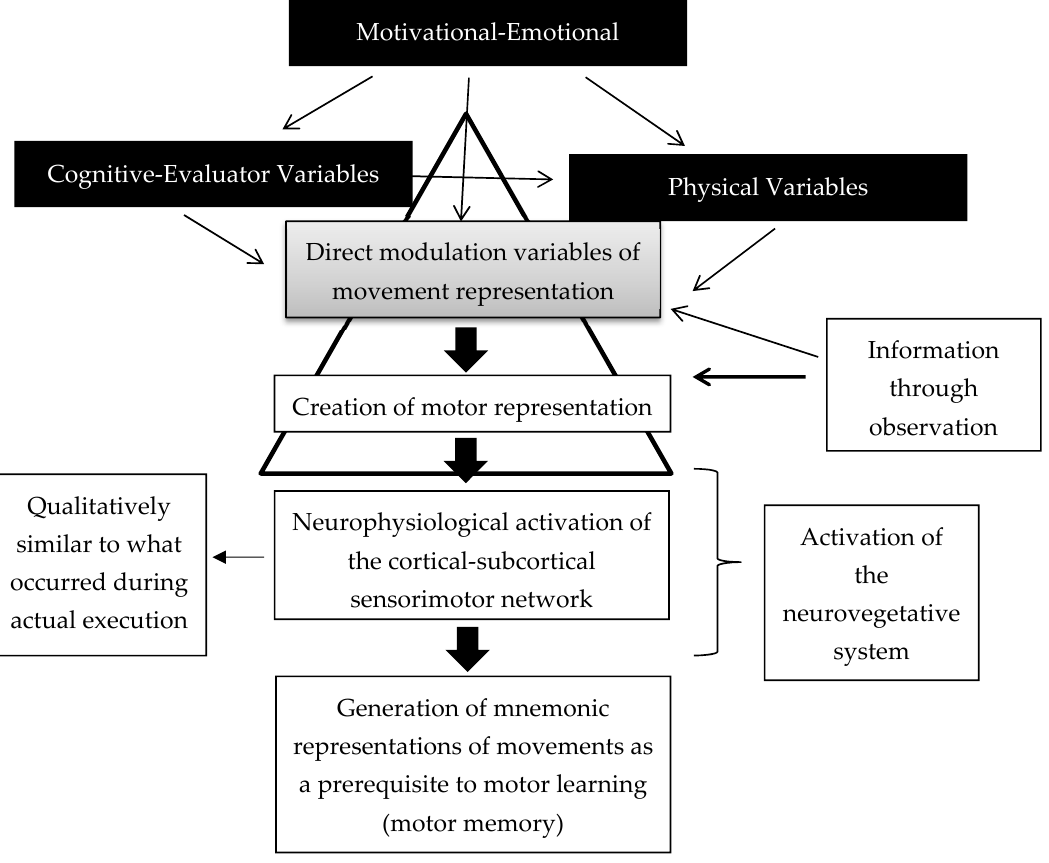
Figure 1. Neurophysiological view of the motor learning process mediated by movement representation techniques.